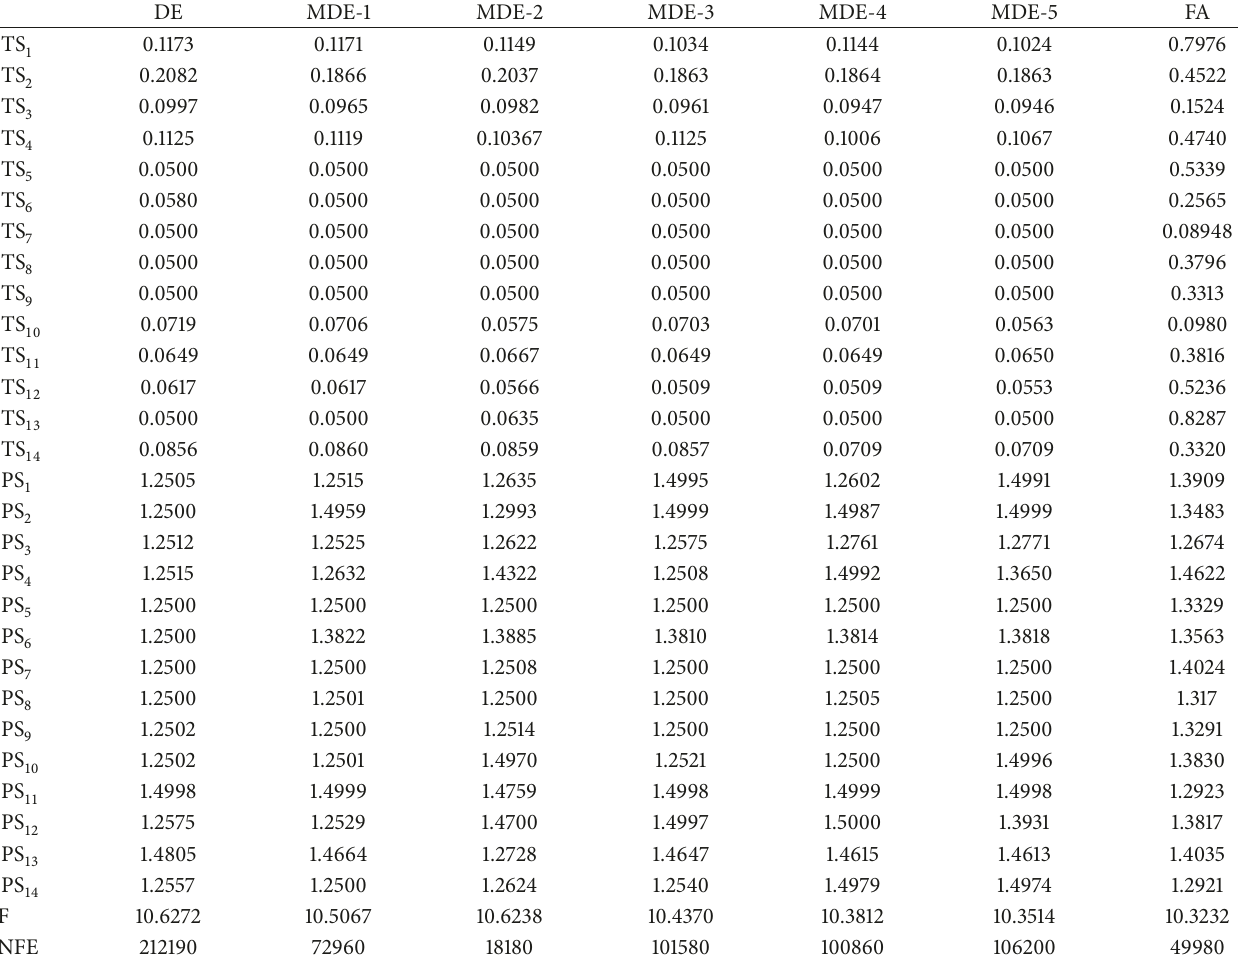
Table 3: Best design variables, objective function values (F), and total number of function evaluations (NFE) for IEEE 6-bus model by DE, modified DE, and firefly